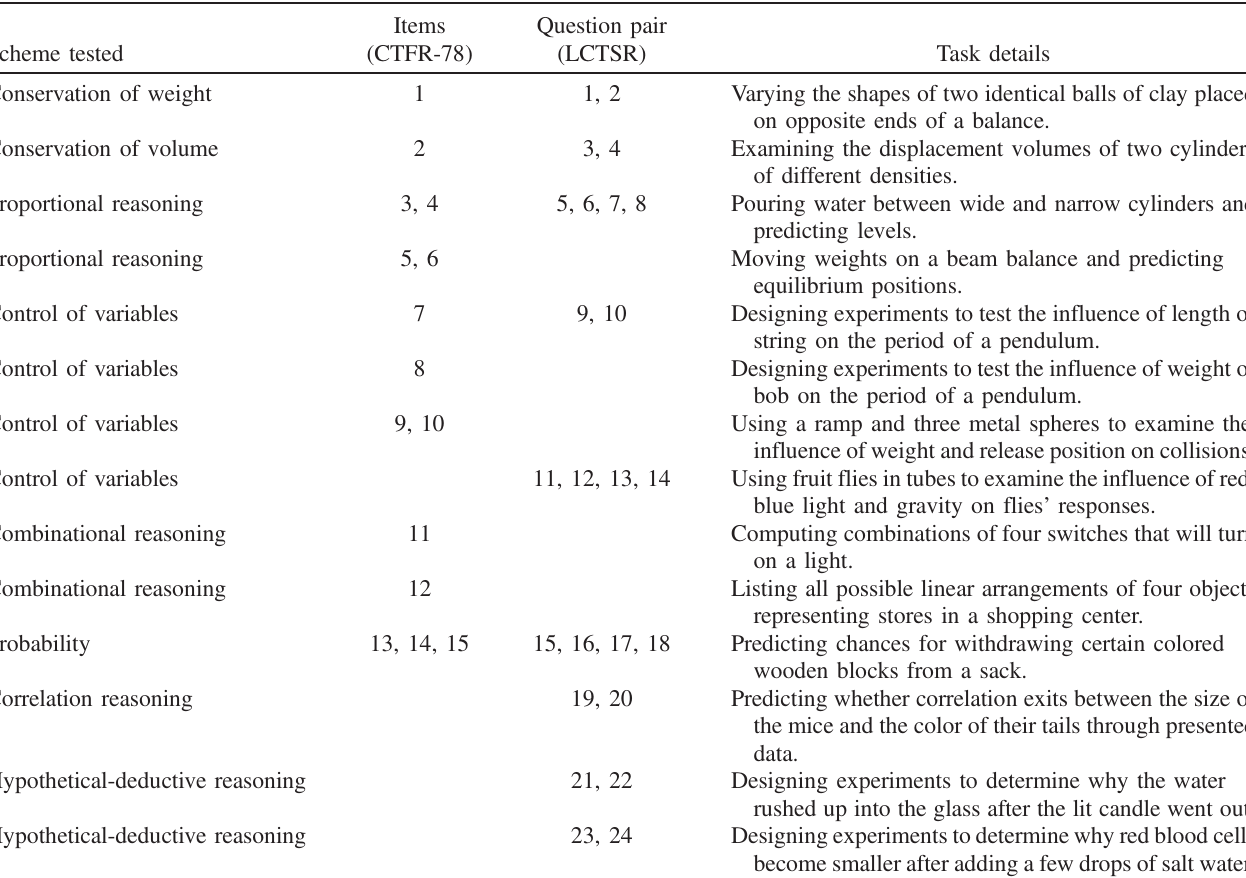
TABLE I. The comparison of CTFR-78 and LCTSR. Scheme